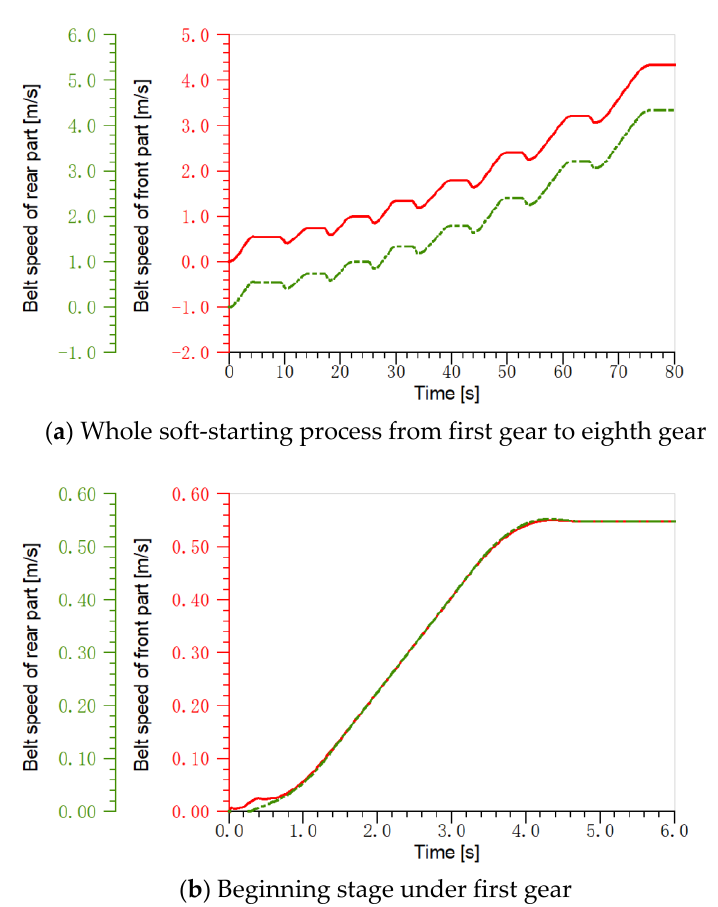
Figure 9. Belt speed curve.